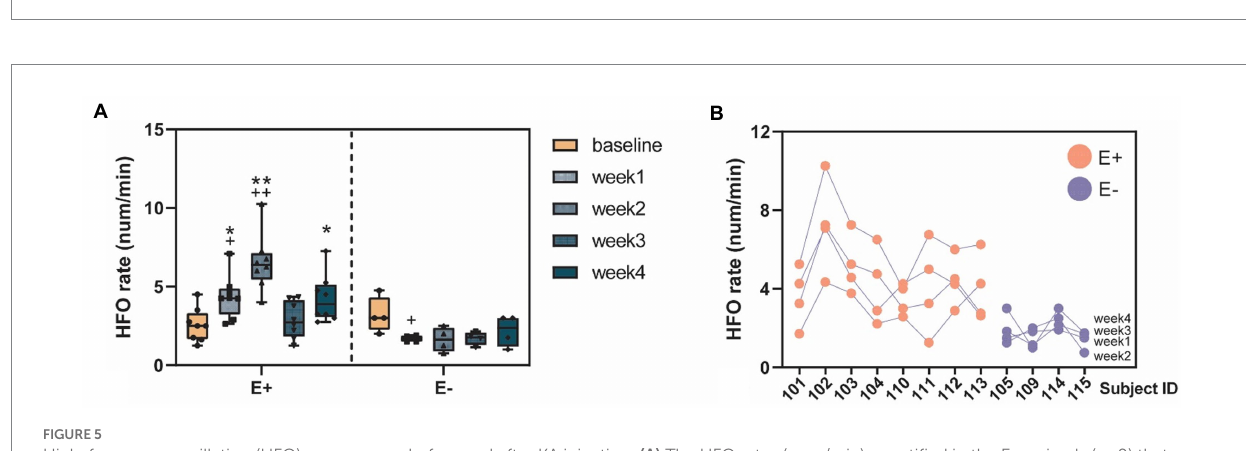
FIGURE 4 Measurement of high-frequency oscillations after the KA injection. (A) LFPs and the high-frequency oscillations (HFOs) of 10 min KA-lesioned EEG signals. (B) Illustration of HFO events: local field potentials (upper) and time-frequency plots (bottom). (C) Channel-wise HFO rate analyzed from the week1 data of 8 animals. (D) The brain atlas showing the electrode implantation. The electrode contacts 1–8 are on the left (L), and contacts 9–16 are located on the right (R) side of the brain. (E) Channel-wise peak frequency of the same group.